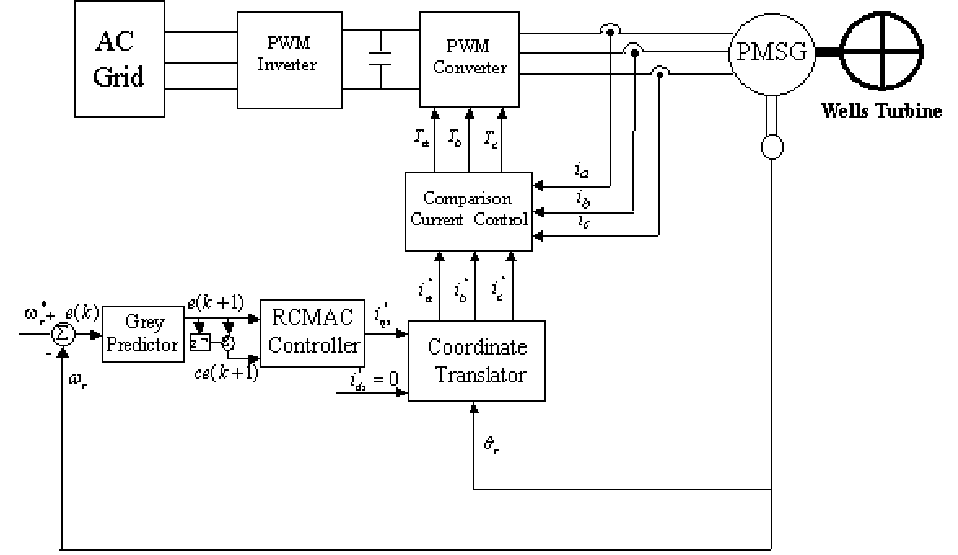
Figure 1. Schematic diagram of a PMSG-based Wells turbine system.